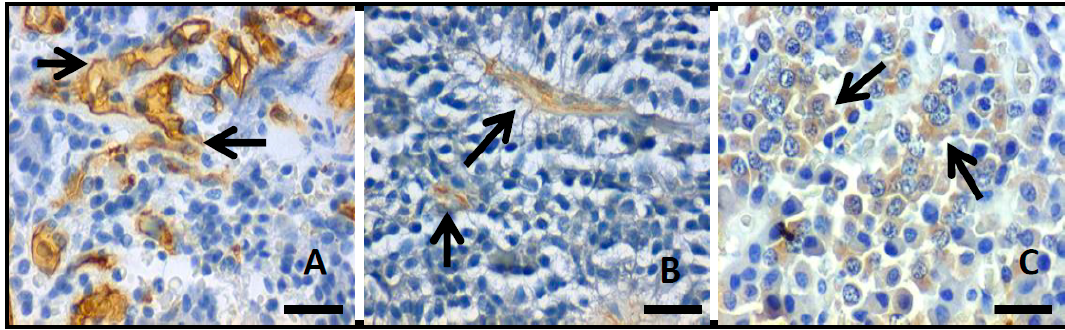
Figure 3. Photomicrographs showing the inmmunohistochemistry reaction (arrows) to ( A ) CD34, ( B ) VEGF, and ( C ) Flk1.; original magnification 400×, scale bar 250 μ m).